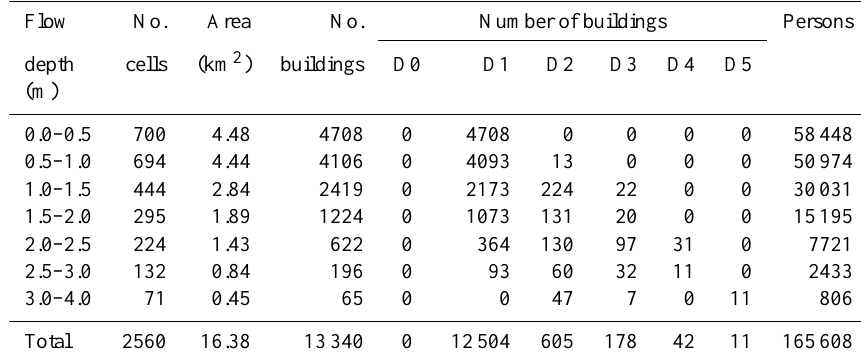
Table A2. Damage to buildings and exposed persons in the case of maximum high-tide conditions.